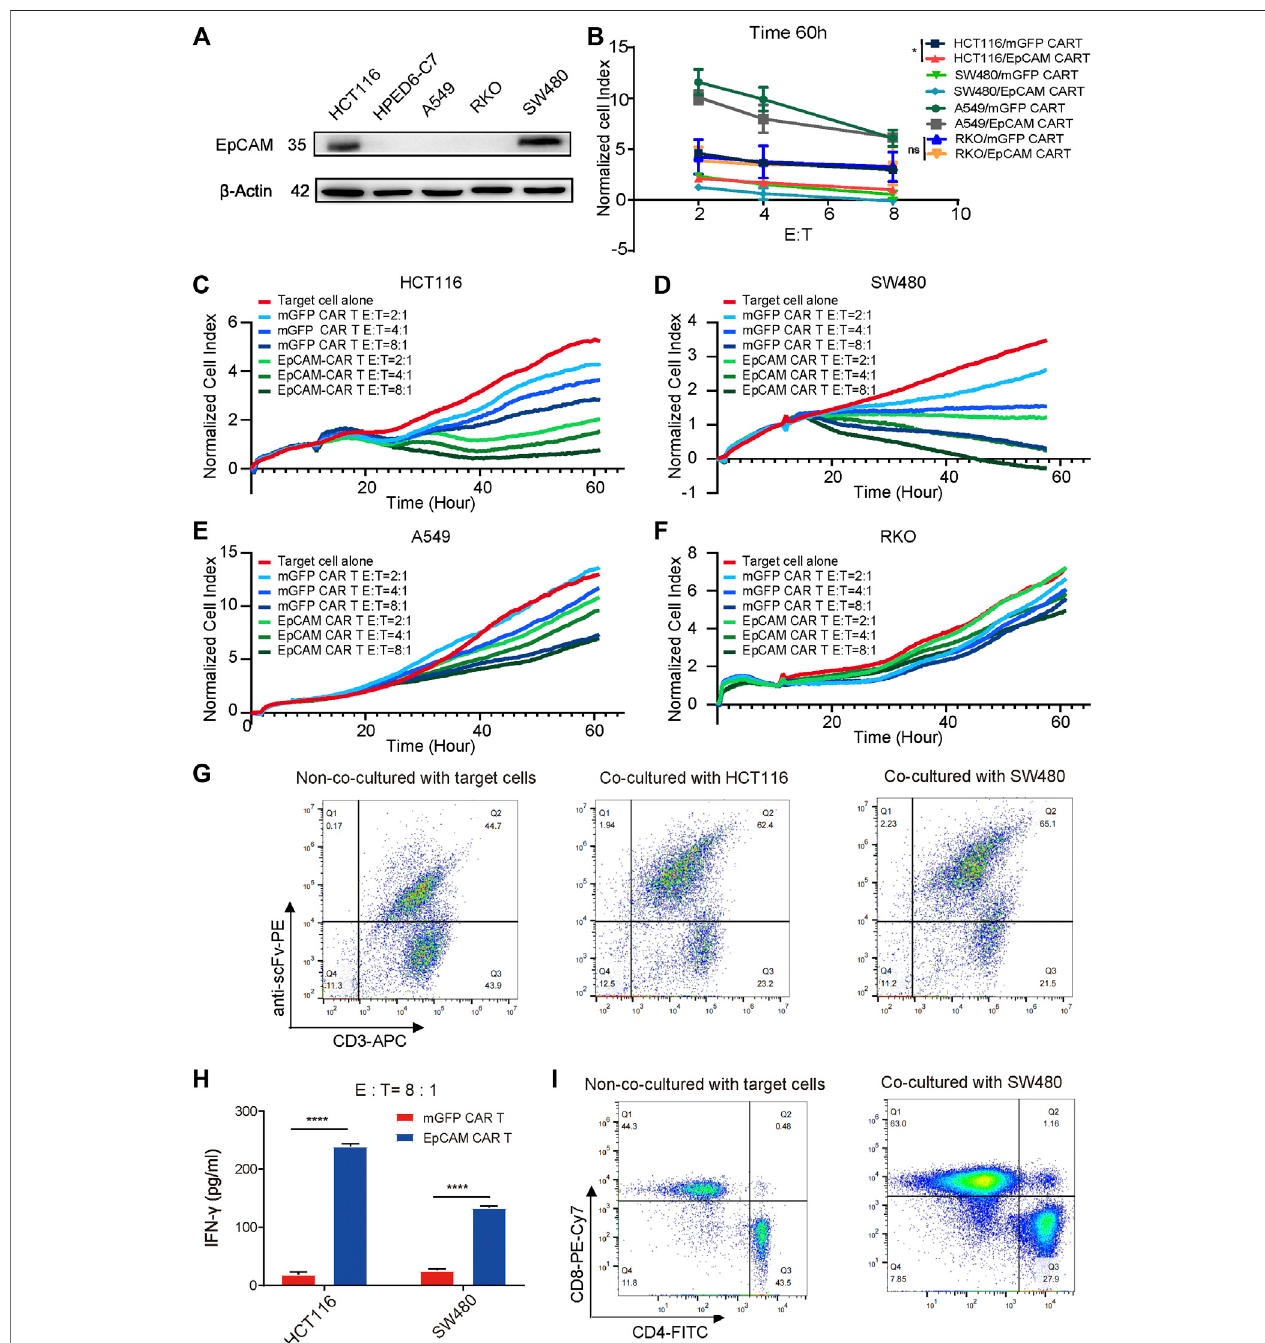
FIGURE 4 | The speci fi c cytotoxicity of EpCAM CAR T against target cells expressing EpCAM antigen. (A) WB was used to detect EpCAM expression on a set of cells. (B) The quantitative analysis of RTCA at time of 60 h of HCT116, SW480, A549 and RKO. The selective cytotoxicity of EpCAM CAR T was analyzed by RTCA, performedasabove.HerethedifferentcelllinesHCT116 (C) ,SW480 (D) ,A549 (E) ,andRKO (F) weretakenastargetcellsrespectivelyandtheeffectorcellswereadded at different E: T of 2:1, 4:1, 8:1, in duplicate. (G) The enrichment of EpCAM CAR T cells after 48 h of co-culture with HCT116 or SW480 cells analyzed by fl ow cytometric analysisof thepercentage of EpCAM CART inCD3+ T cells using anti-CD3 antibody and recombinantbiotinylated protein L binding to scFv. (H) Therelease of cytokine was analyzed by ELISA. The CAR-T cells were co-cultured with target cells at E: T ratio of 8:1 for 48 h and then the released IFN- γ in the supernatant were detected by ELISA. (I) The phenotype changes on transduced T cells after 48 h of coculture with SW480 cells assessed by fl ow cytometry staining for CD3, CD4 and CD8. Results are shown as means ± SEM for experiments performed in duplicate at least. The statistical signi fi cance of differences between groups was determined by the unpaired Student ’ s t test. * p < 0.05; ** p < 0.01, *** p < 0.001.